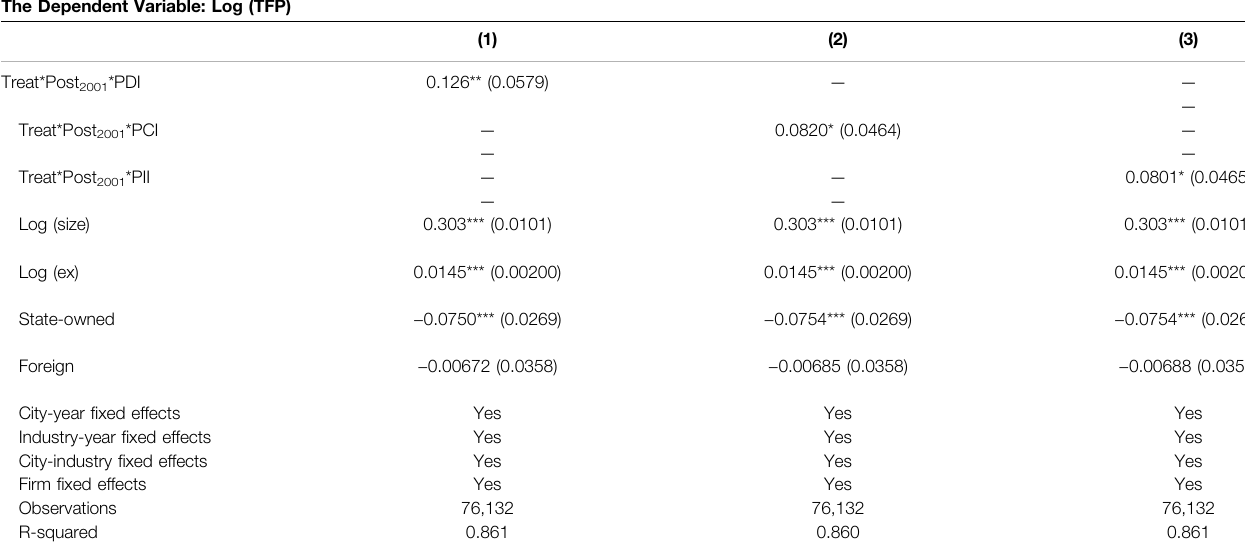
TABLE 1 | Effect of the WDS on improvement of productivity of fi rms.